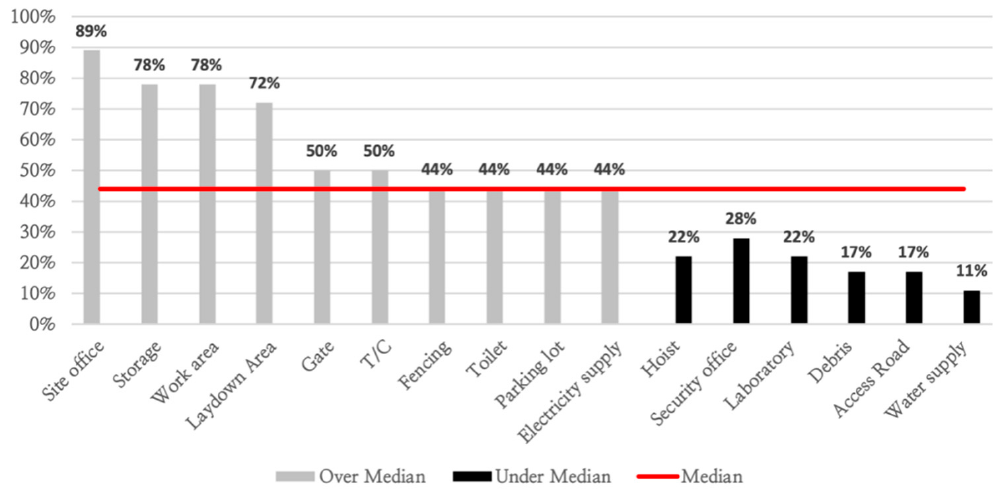
Figure 1. Frequency of temporary facilities appeared in construction site layout planning (CSLP) automation papers.